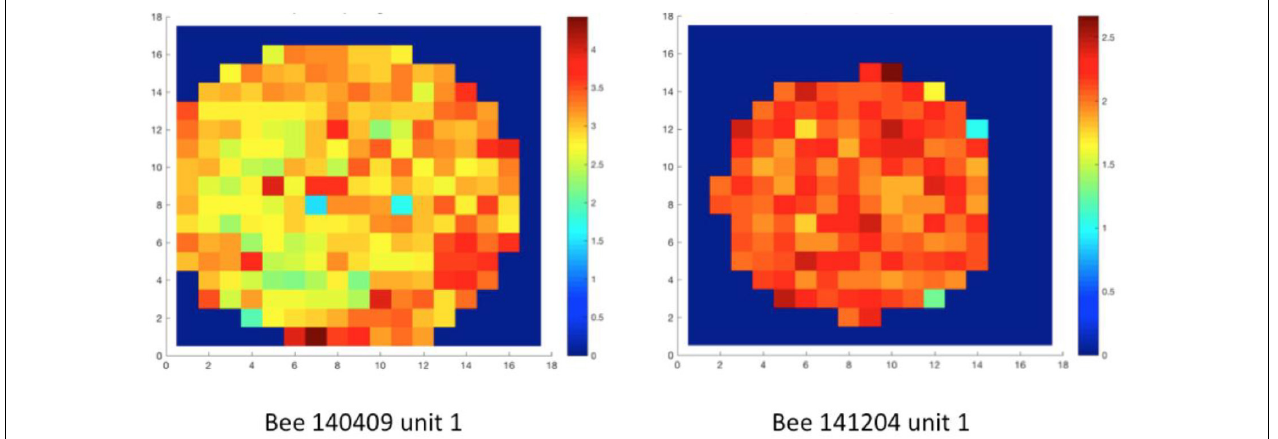
FIGURE 5 | Spatial distribution of neural activity of two units in two different animals. The whole arena was divided into squared bins (each bin 19 mm × 19 mm). False colors represent neuro-activity within each spatial bin, which is the mean spike frequency (Hz) at all tracking points in each bin. Spatial information content (IC) was calculated based on well-established methods (Markus et al., 1994). The ICs of unit 1 in bee # 140409 and unit 1 in bee # 141204 were 0.009 and 0.003, indicating no location-predictive (or so-called “place cell”) property in these units. Data of other units are in Supplementary Figure S1 .